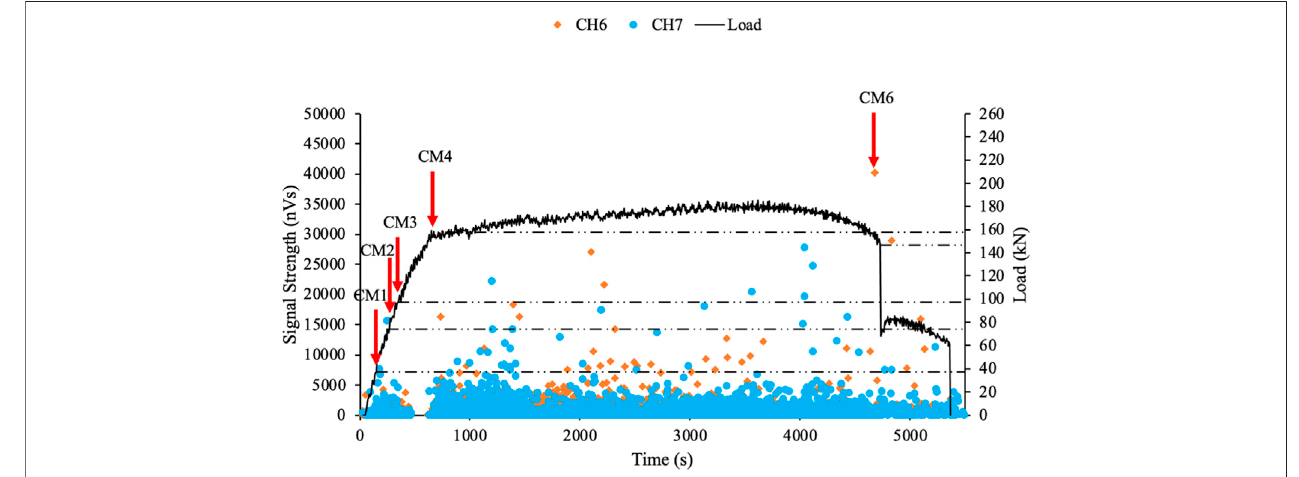
FIGURE 7 | Signal strength distribution and load for Beam S1C.